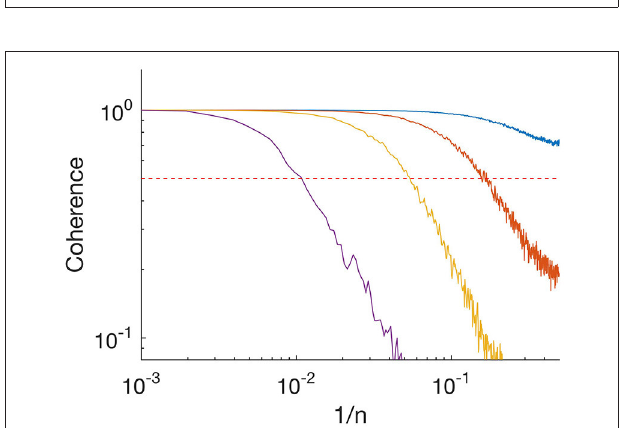
FIGURE 2 | Absolute value of coherence spectrum between input time series and idealized time series. Purple, SNR = 1; yellow, SNR = 3.3; orange, SNR = 10; and blue, SNR = 33. Frequency is plotted as 1/n where n is the length of the segment. Horizontal red dashed line indicates 0.5.